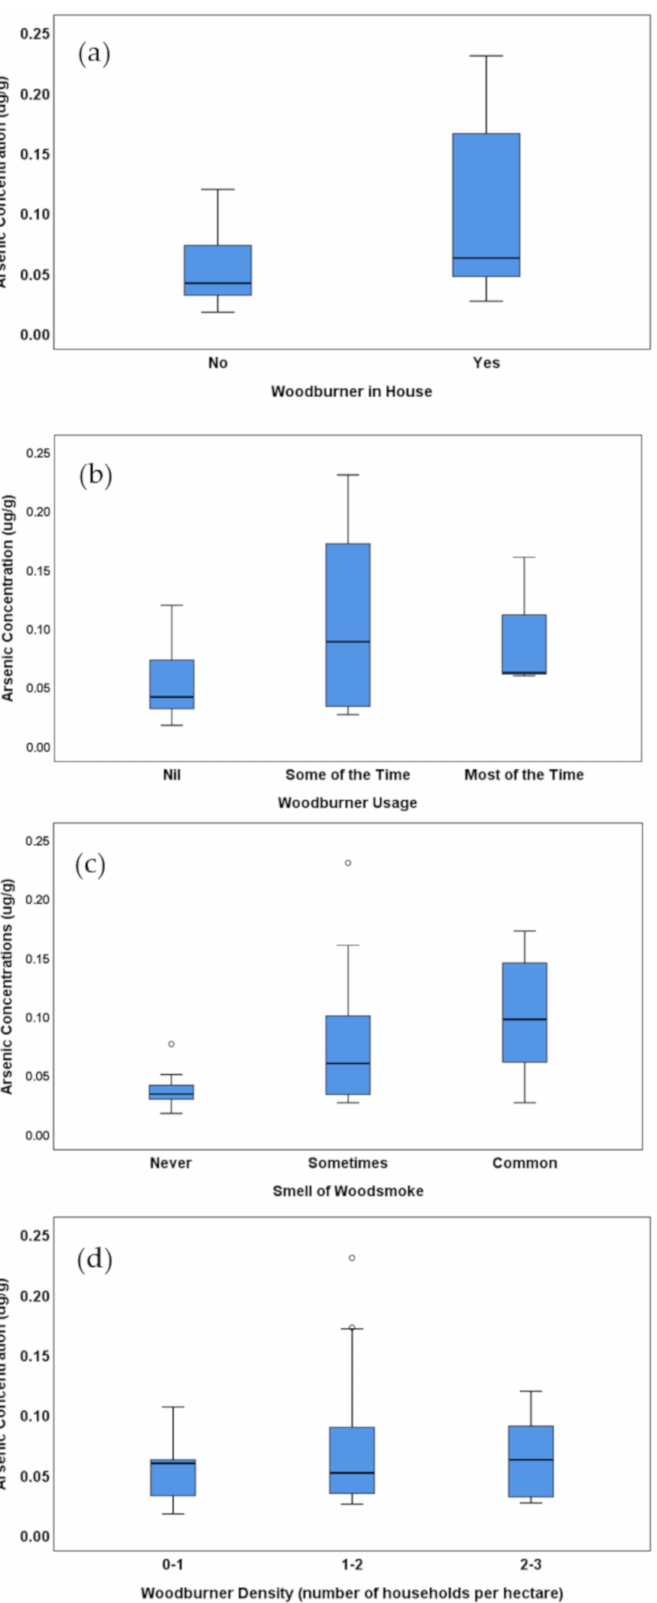
Figure 4. Average arsenic concentrations as a function of ( a ) whether or not the participant has a wood burner in their home, ( b ) the extent of usage of the wood burner (if they have one), ( c ) the extent of woodsmoke smell in their neighbourhood and ( d ) the density of wood burners in the neighbourhood (based on Census 2013